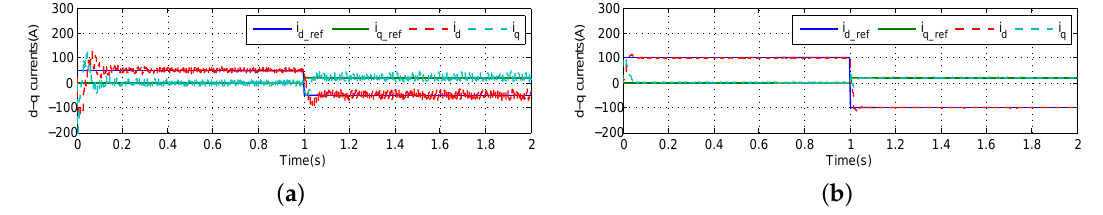
Figure 11. Comparisons for L filter-based GCC with the imaginary circuit created by using the differentiation method. ( a ) Conventional vector control: d - q currents; ( b ) NN vector control: d - q